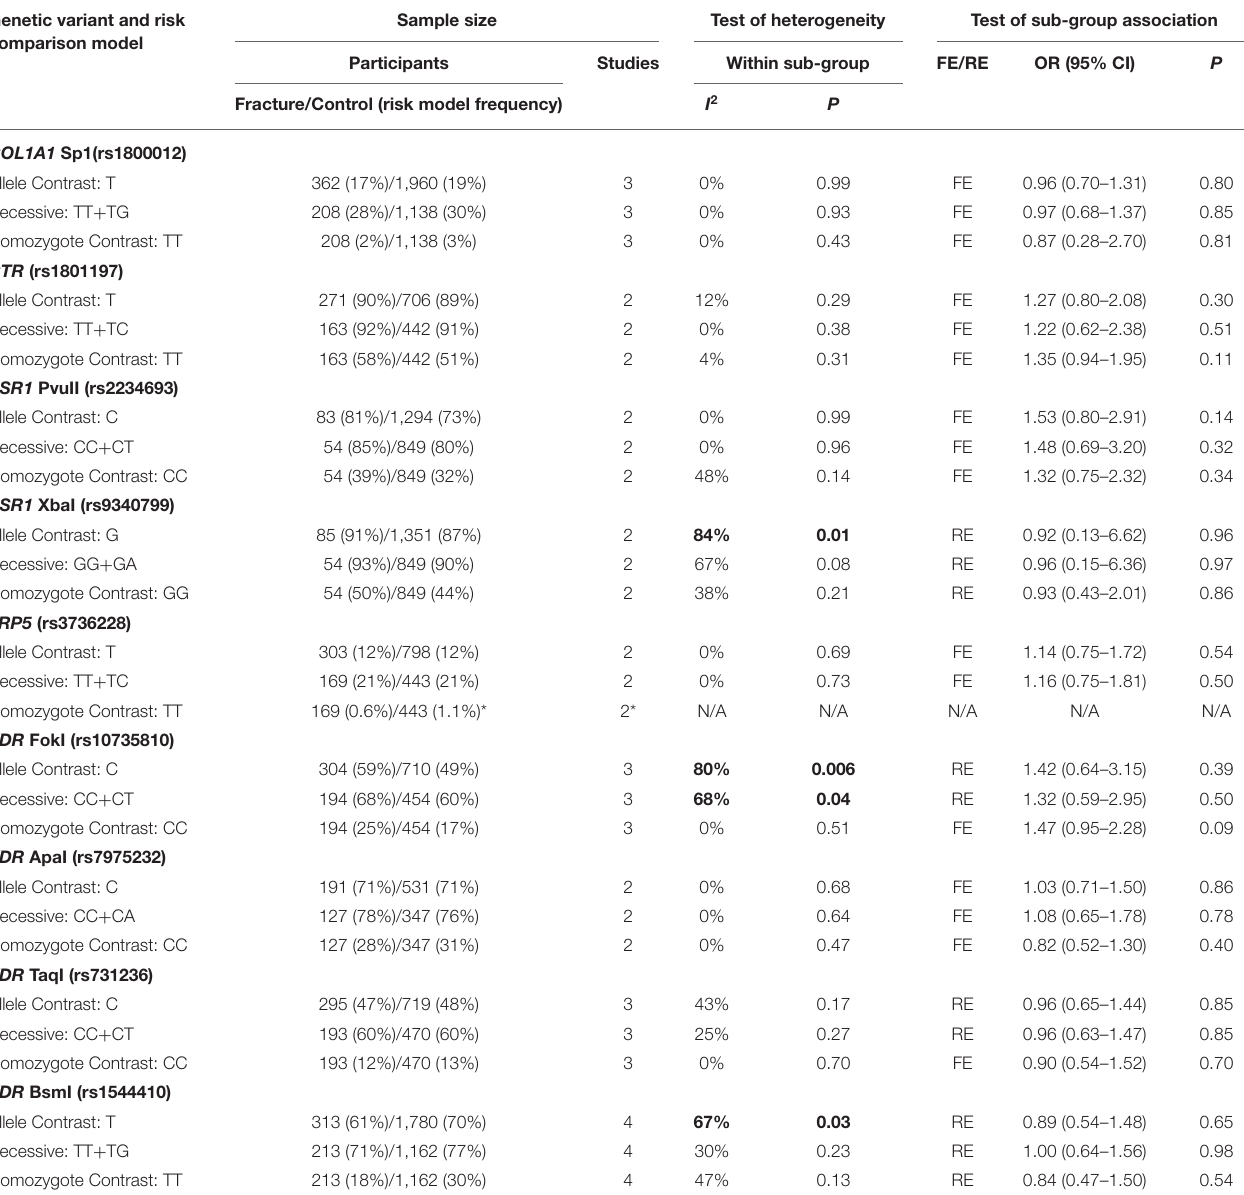
TABLE 5 | Summary effects of case-control association studies for genetic variants associated with fracture occurrence risk in physically active males only. Genetic variant and risk Sample size Test of comparison model